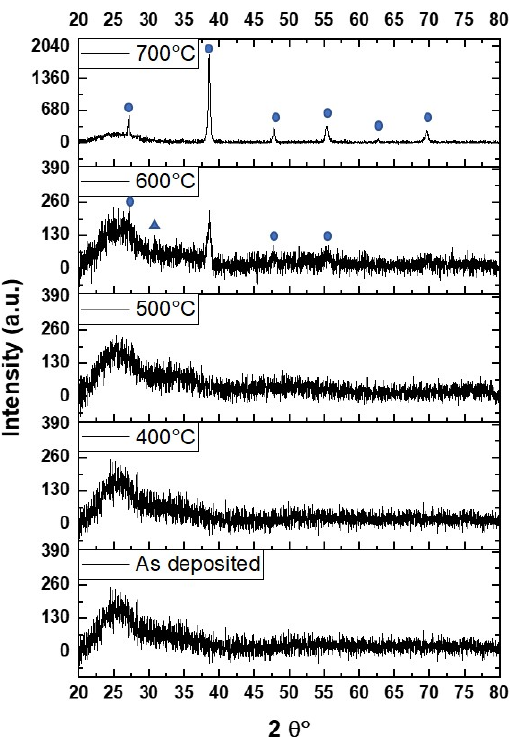
Figure 2. XRD spectra of the LMO film as deposited and after annealing (400 ◦ C, 500 ◦ C, 600 ◦ C and 700 ◦ C). The peaks indicated by the circles represent the perovskite structure La 0.887 MnO 3 and the triangle indicates the Mn 3 O 4 phase.